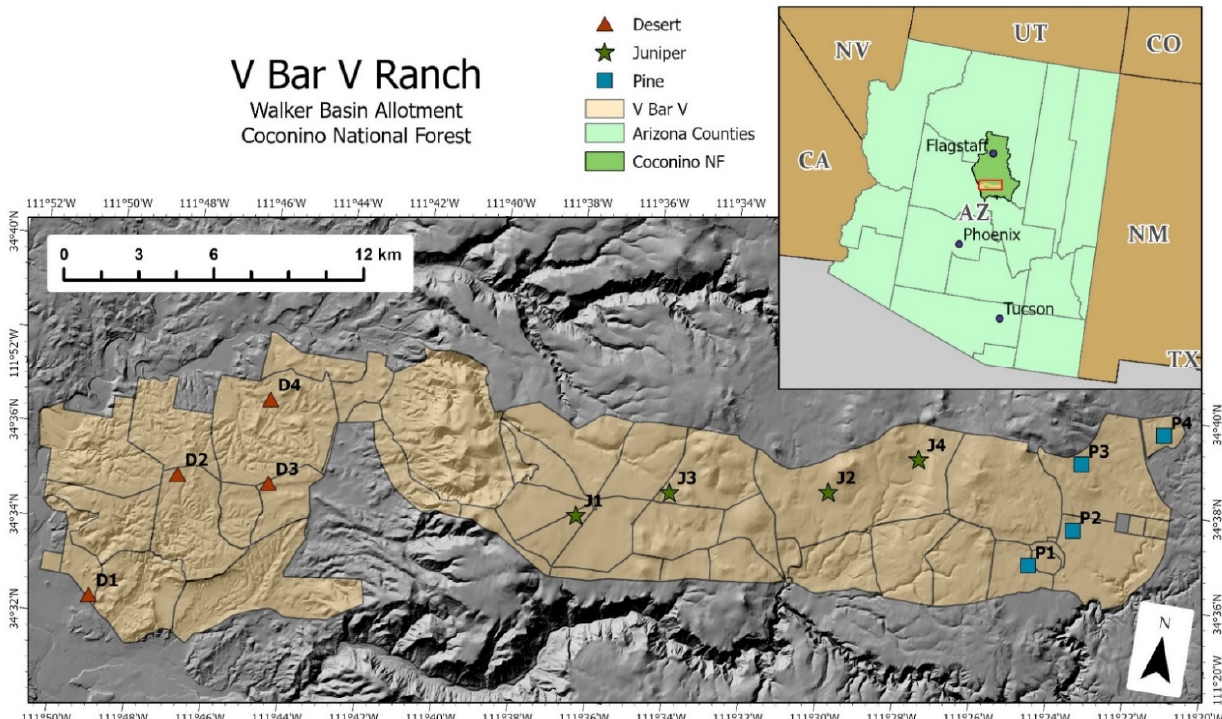
Figure 1. Study site locations for desert, juniper, and pine ecotypes on the V Bar V Ranch in the Coconino National Forest in Central Arizona, USA.